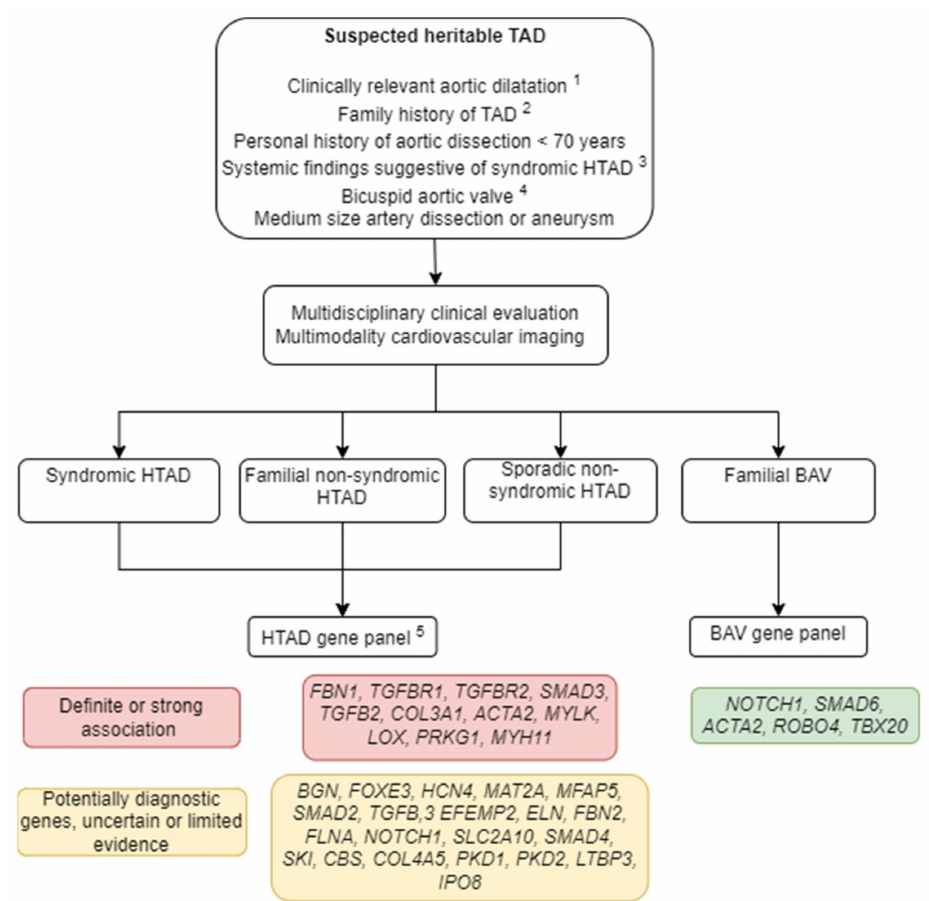
Figure 1. Clinical and genetic evaluation of suspected heritable thoracic aortic disease. HTAD: Heritable thoracic aortic disease; TAD: thoracic aortic disease, BAV: bicuspid aortic valve. 1 This includes one of the following: (a) Aortic root diameter Z-score >3.5 (b) Aortic root diameter Z-score ≥ 3 in patients <18 years (c) Aortic root diameter Z-score 2.5–3.5 in patients 18–60 years (d) Aortic root diameter Z-score 2.5–3.5 without hypertension in patients >60 years. 2 1st- or 2nd-degree relative with aortic dissection or aneurysm aged <60 years or sudden cardiac death <45 years. 3 Ectopia lentis, hypertelorism, bifid uvula, premature and extensive osteoarthritis, club feet, cleft palate and other systemic features. 4 Familial cases, syndromic or extra phenotypic characteristics, young patients with severe disease. 5 In familial and/or syndromic cases consider exome sequencing, copy number variant testing if next-generation sequencing is negative and there is high clinical suspicion of HTAD or for research